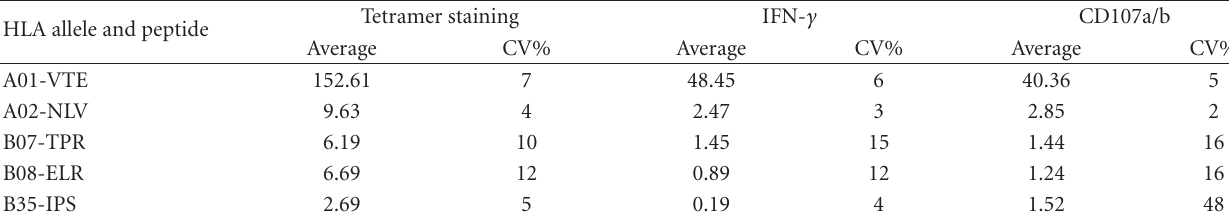
Table 3: Precision between assays.